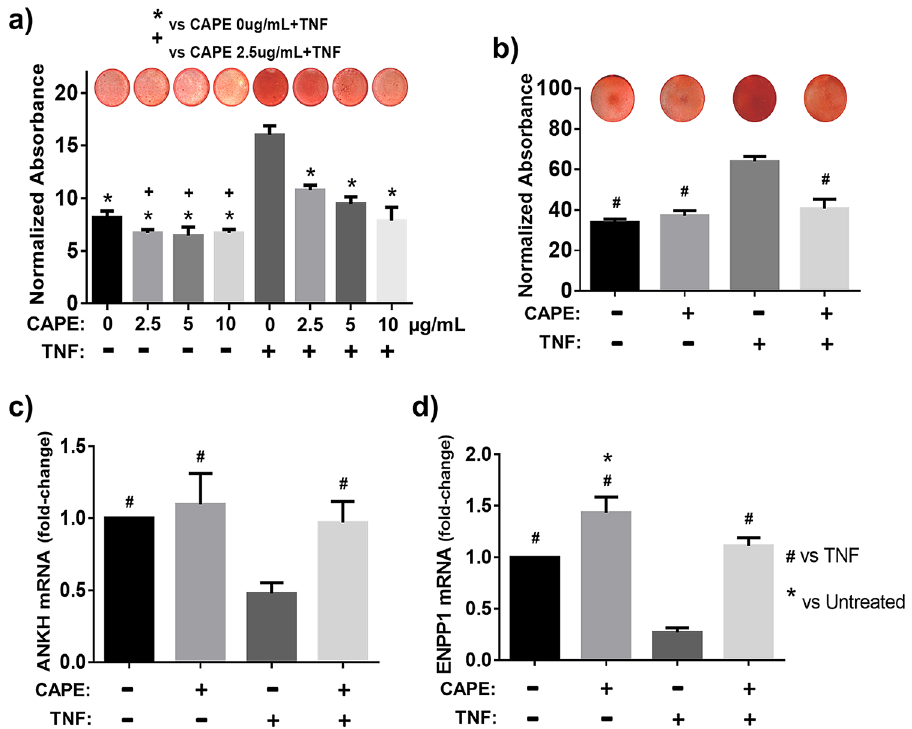
Figure 4. Inhibition of NF-κB pathway diminishes TNF-induced mineralization. ( a ) Representative image of Alizarin red staining and spectrophotometric quantifications of the staining (1 week): pretreatment of TNAP cells for 1 h with CAPE diminished the TNF effect on mineral deposition in a dose-dependent matter (n = 4); ( b ) representative image of Alizarin red staining and spectrophotometric quantifications of the staining (2 weeks) (n = 6); ( c ) qPCR results: pretreatment of TNAP cells for 1 h with 5 µg/mL CAPE diminished the effect of TNF on ANKH and ( d ) ENPP1 gene expression (n = 4). Significance represents p < 0.05. Data analyzed using One- way